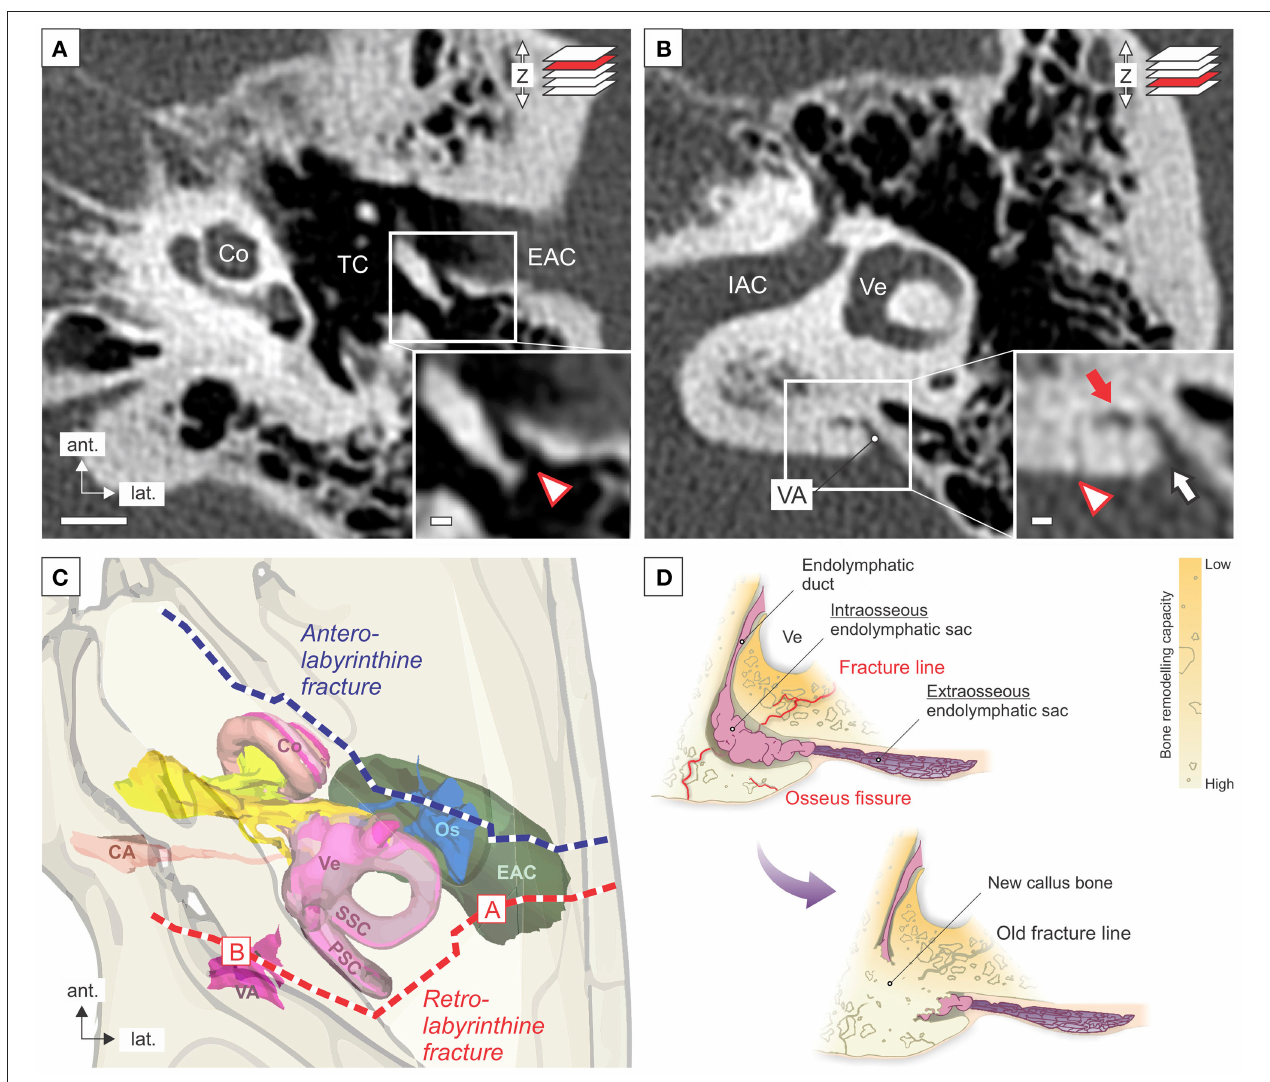
FIGURE 4 | Proposed retrolabyrinthine fracture course in the present case and its impact on the VA. (A,B) Old fracture signs (age 44) in the posterior wall of the external auditory canal [EAC; (A) ] and in the opercular region (B) on HRCT imaging. (C) Illustration of the trajectory of the proposed fracture in the present case (red line) and the common trajectory of a longitudinal temporal bone fracture (blue line). Localizations of these fracture signs are marked in (C) . (C) Illustration of the proposed fracture trajectory in the present case (red line), as well as a common longitudinal fracture (blue line). (D) Hypothesized mechanism of secondary fracture healing and new callus bone formation with consecutive blockage of the VA and separation of the eES in a fracture that courses through the VA outside the non-remodeling otic capsule bone. Scale bars: (B) , 5mm; ( B , inlay), 1mm. The illustration in (C) was generated using the 3D viewer of the Human Temporal Bone model [Eaton Peabody Laboratories, MEEI,